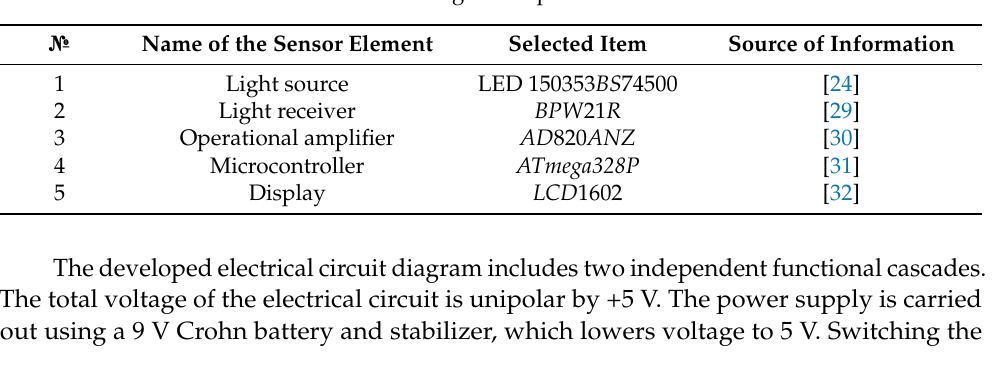
Table 3. The main elements of the sensor being